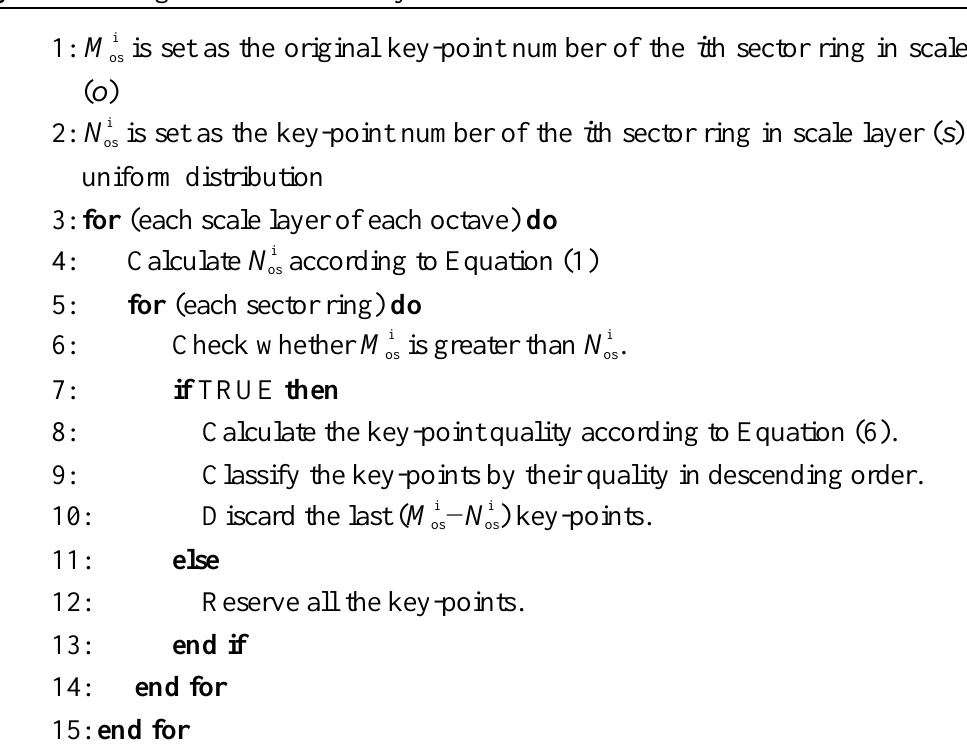
Algorithm 1 Algorithm of uniformly distributed feature